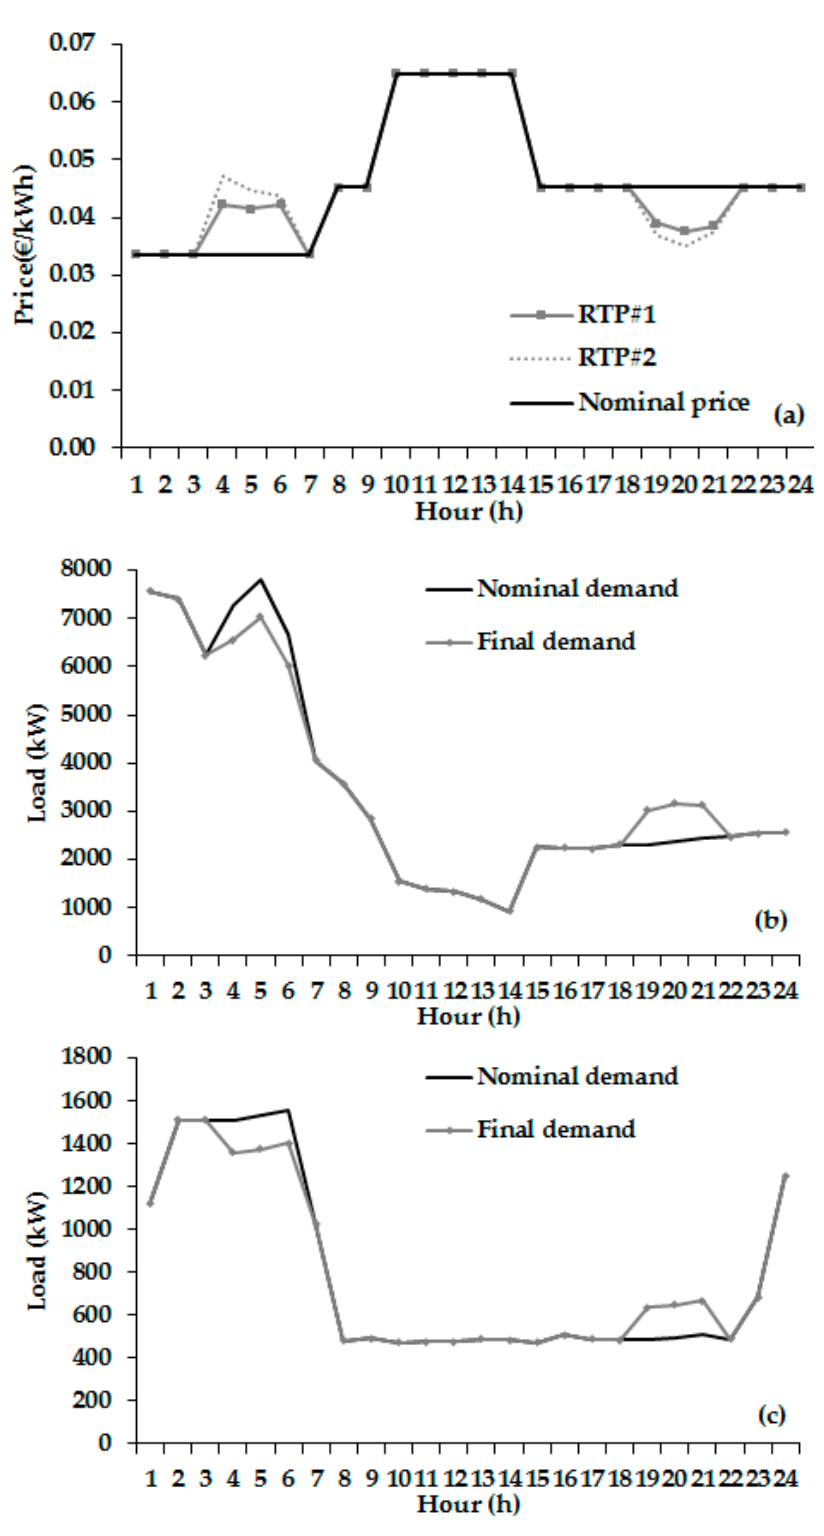
Figure 16. LS objective results with linear DR model: ( a ) Nominal price and RTP; ( b ) nominal and final demand of consumer 1 and ( c ) nominal and final demand of consumer 2.